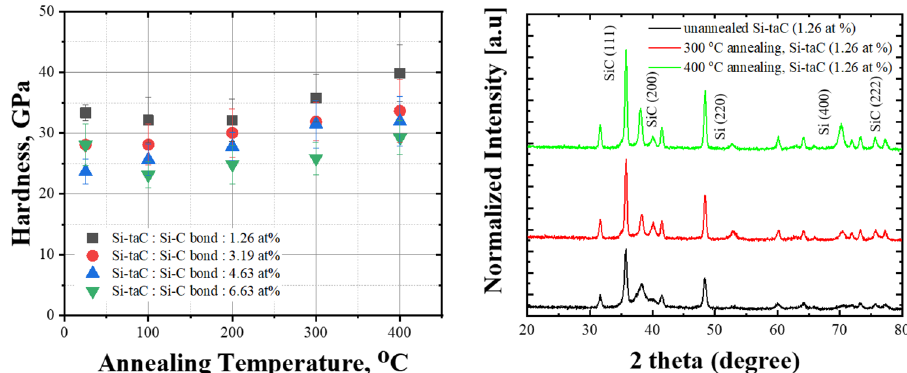
Figure 9. Hardness of Si/SiC/ta-C composite (Si–ta-C) coatings after annealing at different temperatures and X-ray diffraction (XRD) patterns of Si-ta-C (1.26 at.% Si) before and after annealing at 300 and 400 °C.